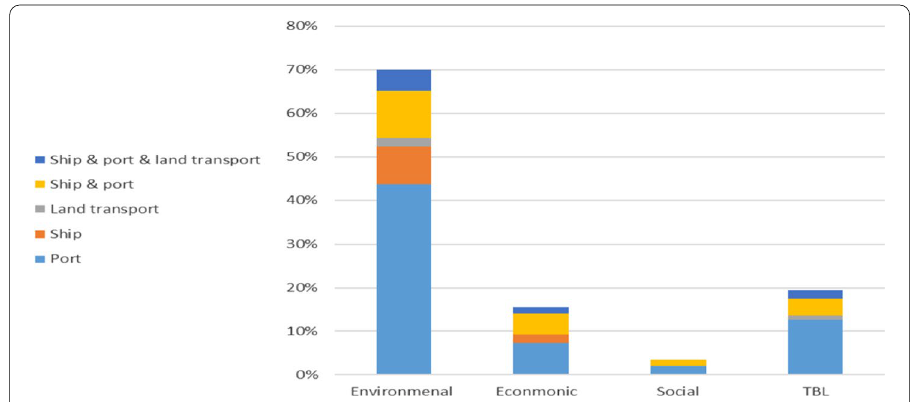
Fig. 4 Percentage of studies coverage by dimensions of sustainability and internal and external